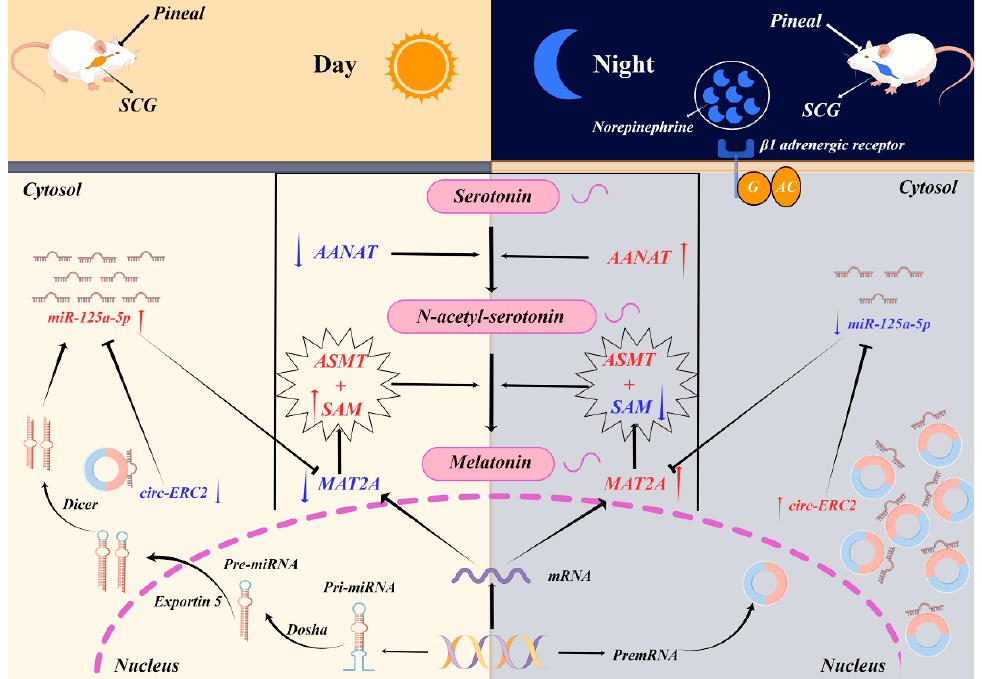
Figure 7. circ-ERC2 is involved in melatonin synthesis through the miR-125a-5p/MAT2A axis. This figure is drawn using Figdraw (https://www.figdraw.com/static/index.html#/, accessed on 10 Sep- tember 2022). The unique authorization code is IUWYA559da. 10 September 2022). The unique authorization code is